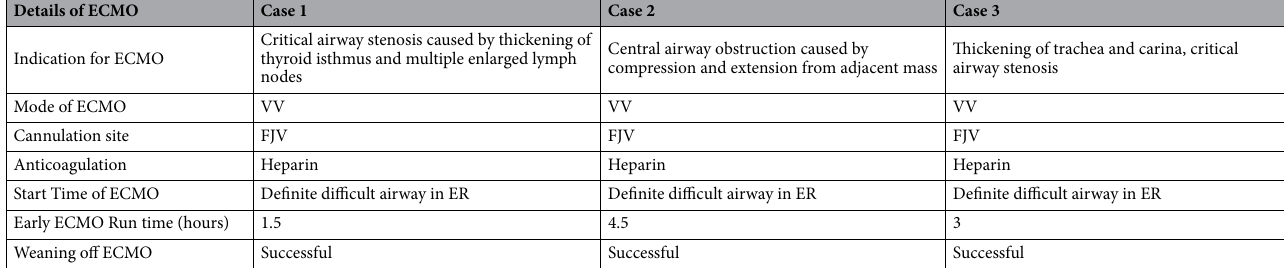
Table 3. Details of early ECMO initiation. ECMO, extracorporeal membrane oxygenation; VV, venovenous; FJV, femoral and internal jugular vein; ER, emergency room.